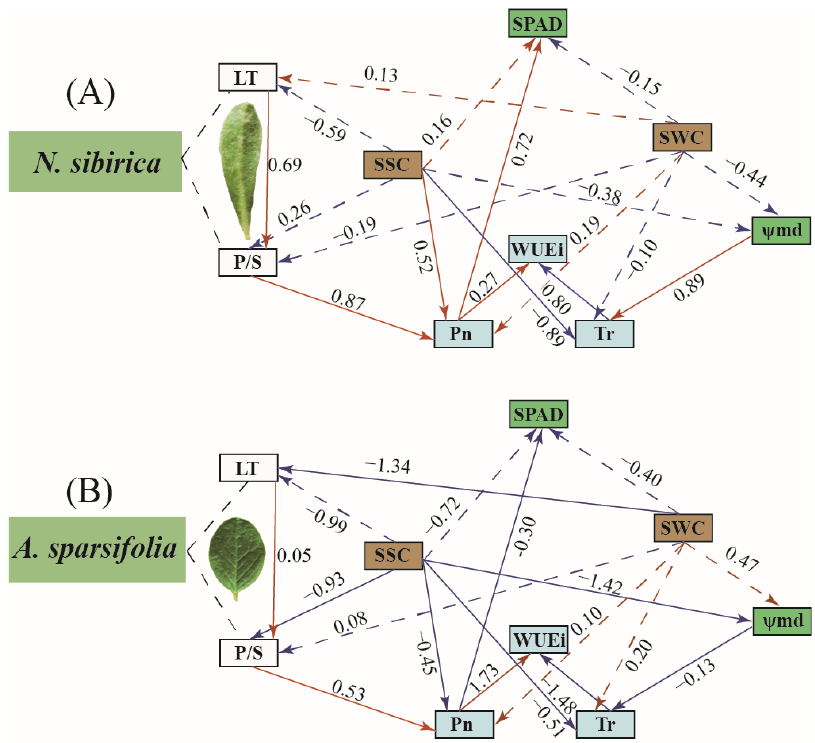
Figure 6. Path coefficients of photosynthesis and other factors. ( A ) Path coefficients of N. sibirica ; ( B ) Path coefficients of A. sparsifolia . The dotted line indicates that the path coefficient is not significant, the solid line indicates that the path coefficient is significant, the red line indicates that the path coefficient is positive, and the blue line indicates that the path coefficient is negative.